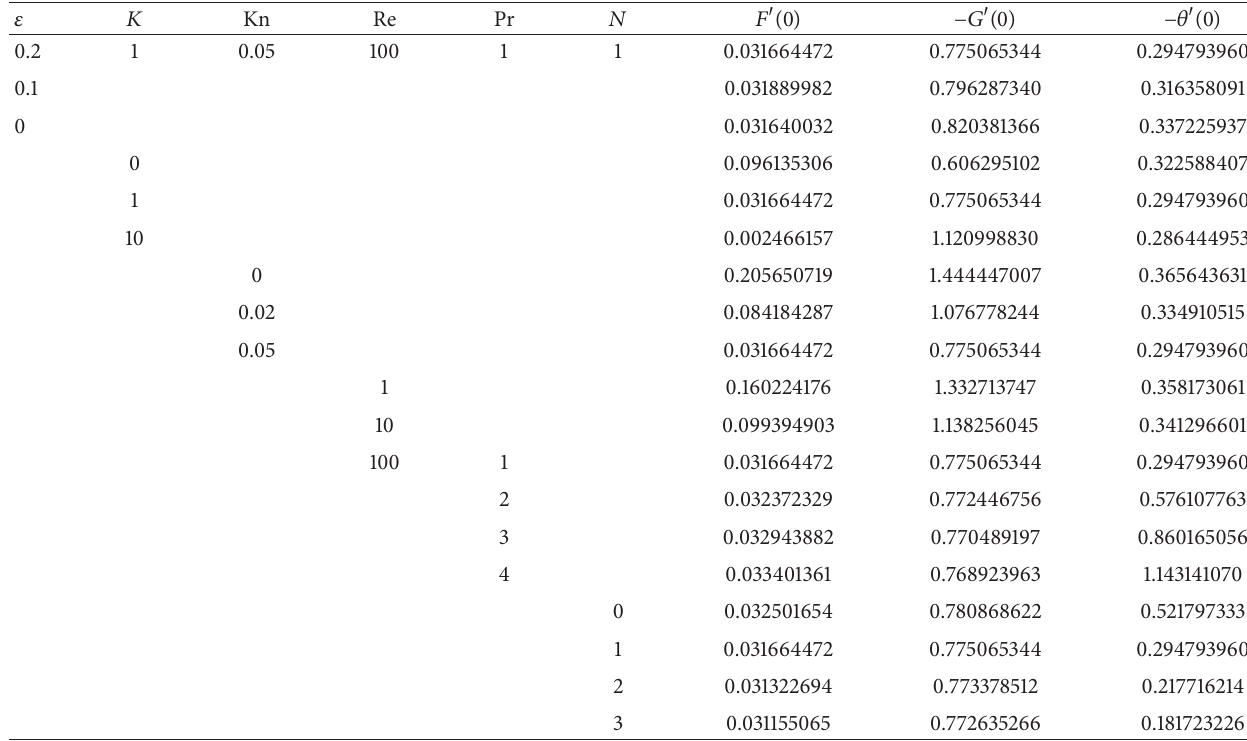
Table 1: Variation of 𝐹 󸀠 (0) , −𝐺 󸀠 (0) , and −𝜃 󸀠 (0) at the disk surface with 𝜀 , 𝐾 , Kn, Re, Pr, and 𝑁 parameters, when 𝑊 𝑠 = −1